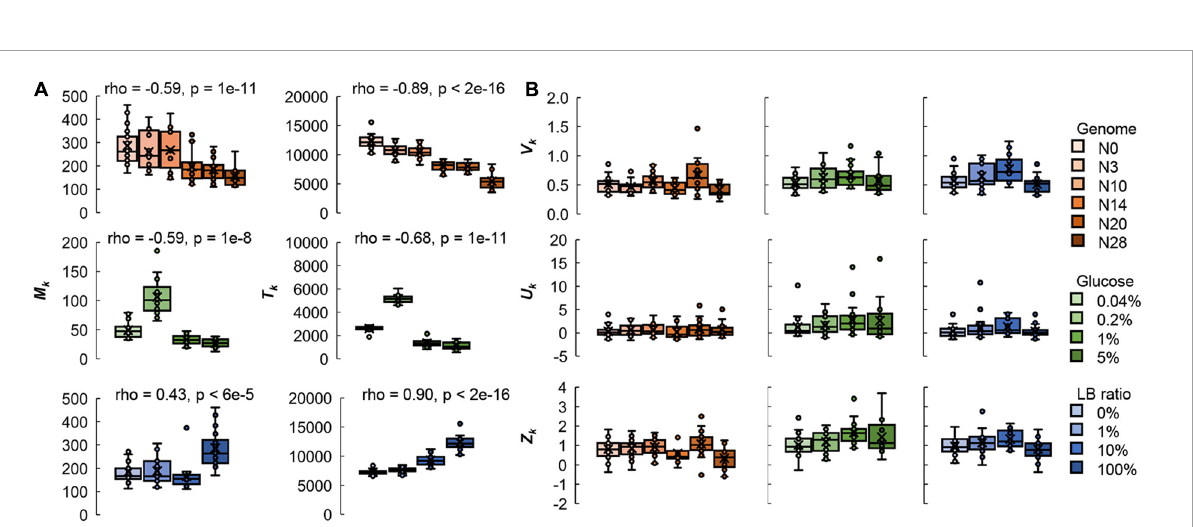
FIGURE3 Boxplots of the global parameters relating to the size distribution of colonies. (A) Genomic and nutritional gradient-dependent parameters. The mean size ( M k ) and total area ( T k ) of the colonies on individual plates are shown. (B) Genomic and nutritional gradient independent parameters. The variation ( V k ) of the colonies and the kurtosis ( U k ) and skewness ( Z k ) of the distribution of colony size are shown. Tiny circles and crosses represent the parameters of individual plates of 25–75 colonies and their mean values, respectively. Gradations in orange, green, and blue indicate the genome size from the wild type to the reduced ones ( N = 111), the concentration gradient of glucose in the minimal medium M63 ( N = 78) and the ratio gradient of LB in the mixed medium M63LB ( N = 80). The individual data points can be found in Supplementary Figure 3 . Spearman’s correlation coefficients and the p -values, which were of statistical significance, are